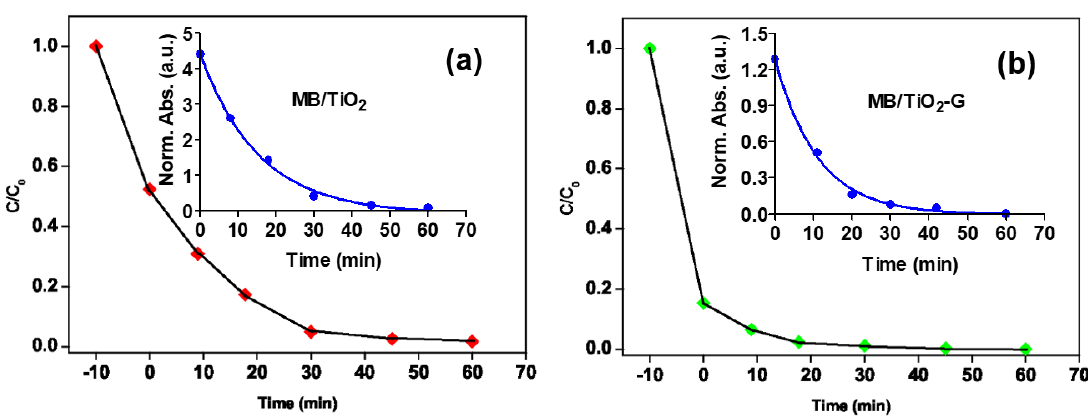
Figure 7. ( a ) Plot of C/C 0 for the degradation of methylene blue (MB) dye in the presence of TiO 2 with different time intervals at UV light. ( b ) The same process for the MB/p-C/TiO 2 suspensions under the same conditions. The region between − 10 and 0 min indicates the extent of adsorption of the MB dye by dark conditions. The inserts show the first-order kinetics of the photodegradation of the MB dye.